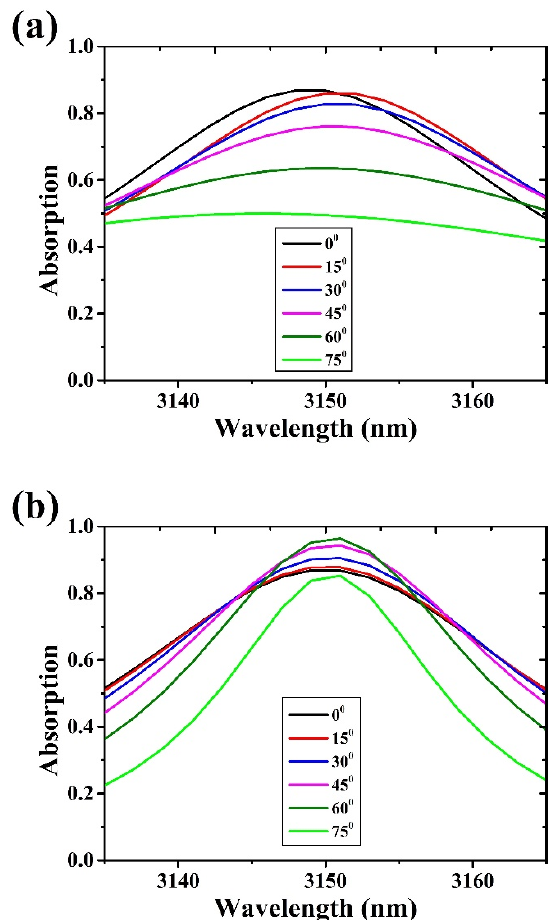
Figure 10. SLG optical absorption as a function of wavelength for different incident angles at ( a ) TE and ( b ) TM polarization.